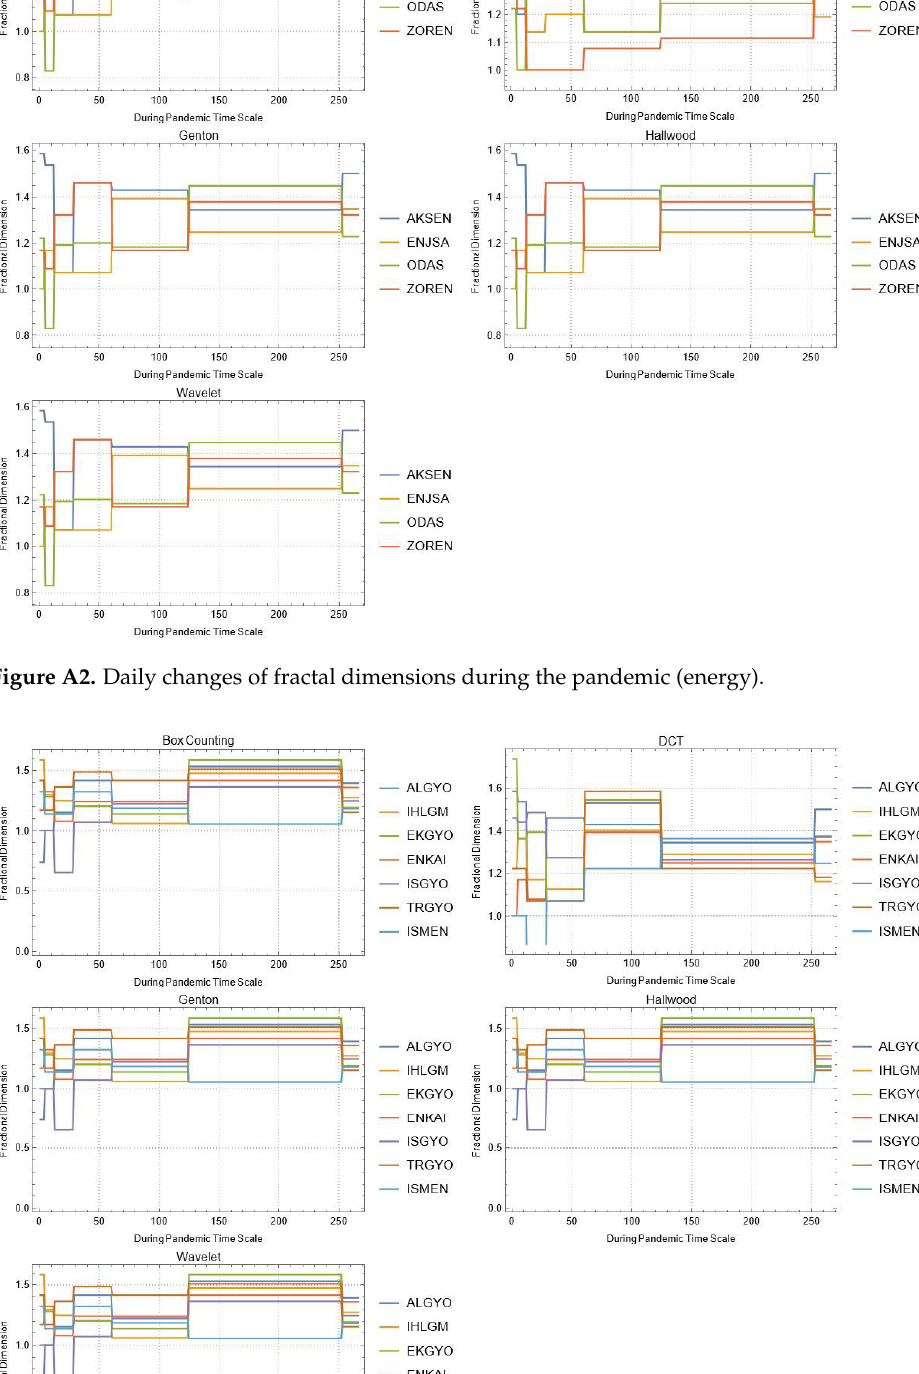
Figure A1. Daily changes of fractal dimensions during the pandemic (social).